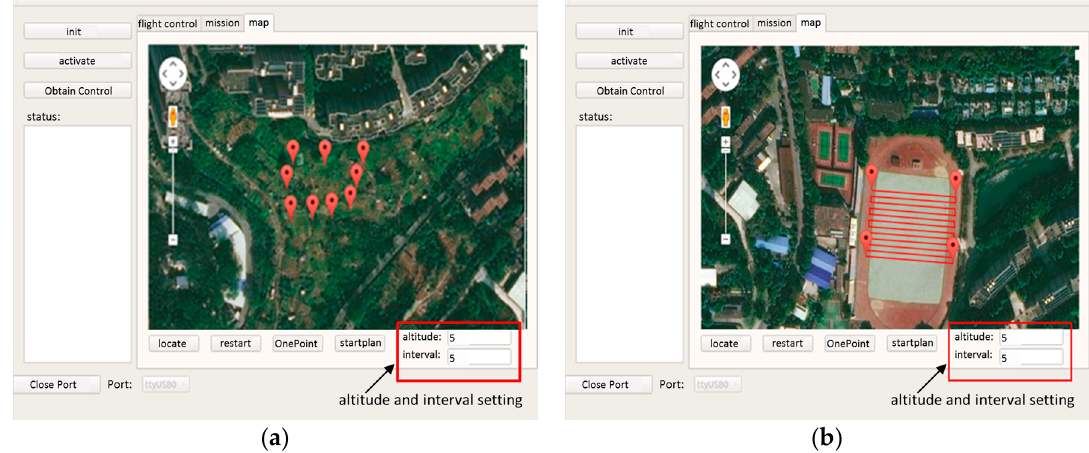
Figure 2. The map module. ( a ) User interface of the map module. ( b ) One example of route